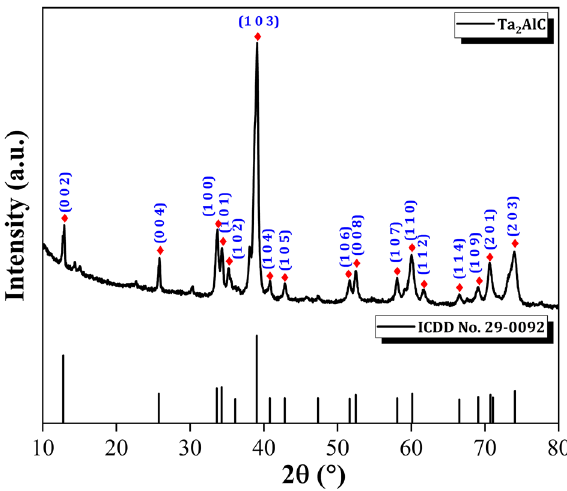
Figure 1. XRD pattern of the Ta 2 AlC MAX